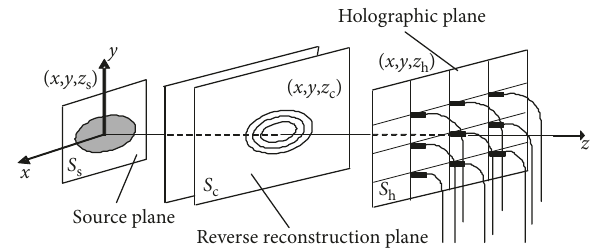
Figure 2: Sketch map of sound field propagation